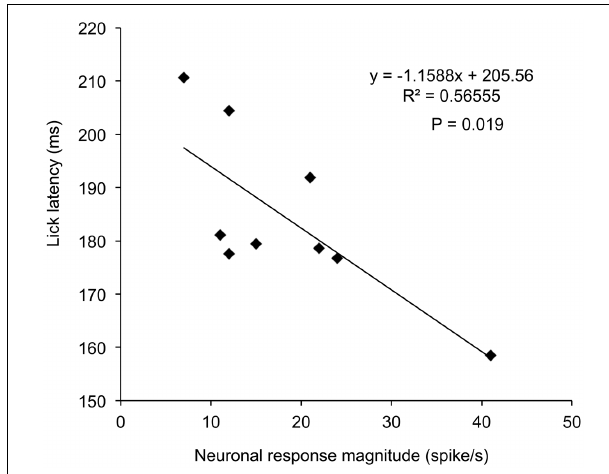
FIGURE 5 | Relationships between response magnitudes to the CSs and lick latencies in session 3 in the disengagement-related neuron shown in Figure 3. There was a significant negative correlation between the response magnitudes and lick latencies ( P = 0.019, simple linear